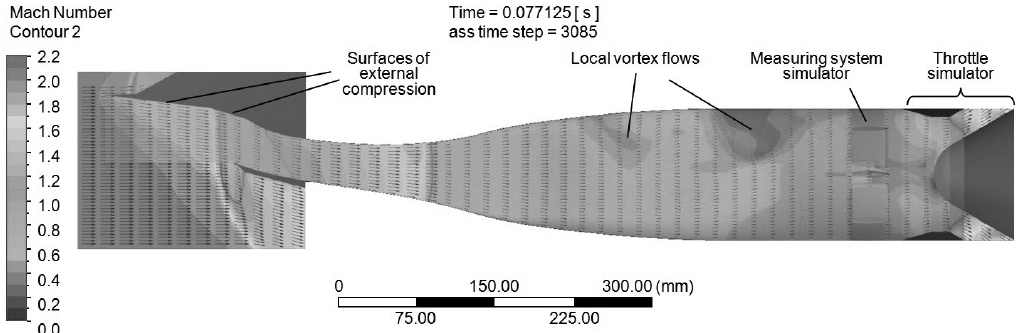
Figure 13. Field distribution of the instantaneous flow velocity in the symmetry plane